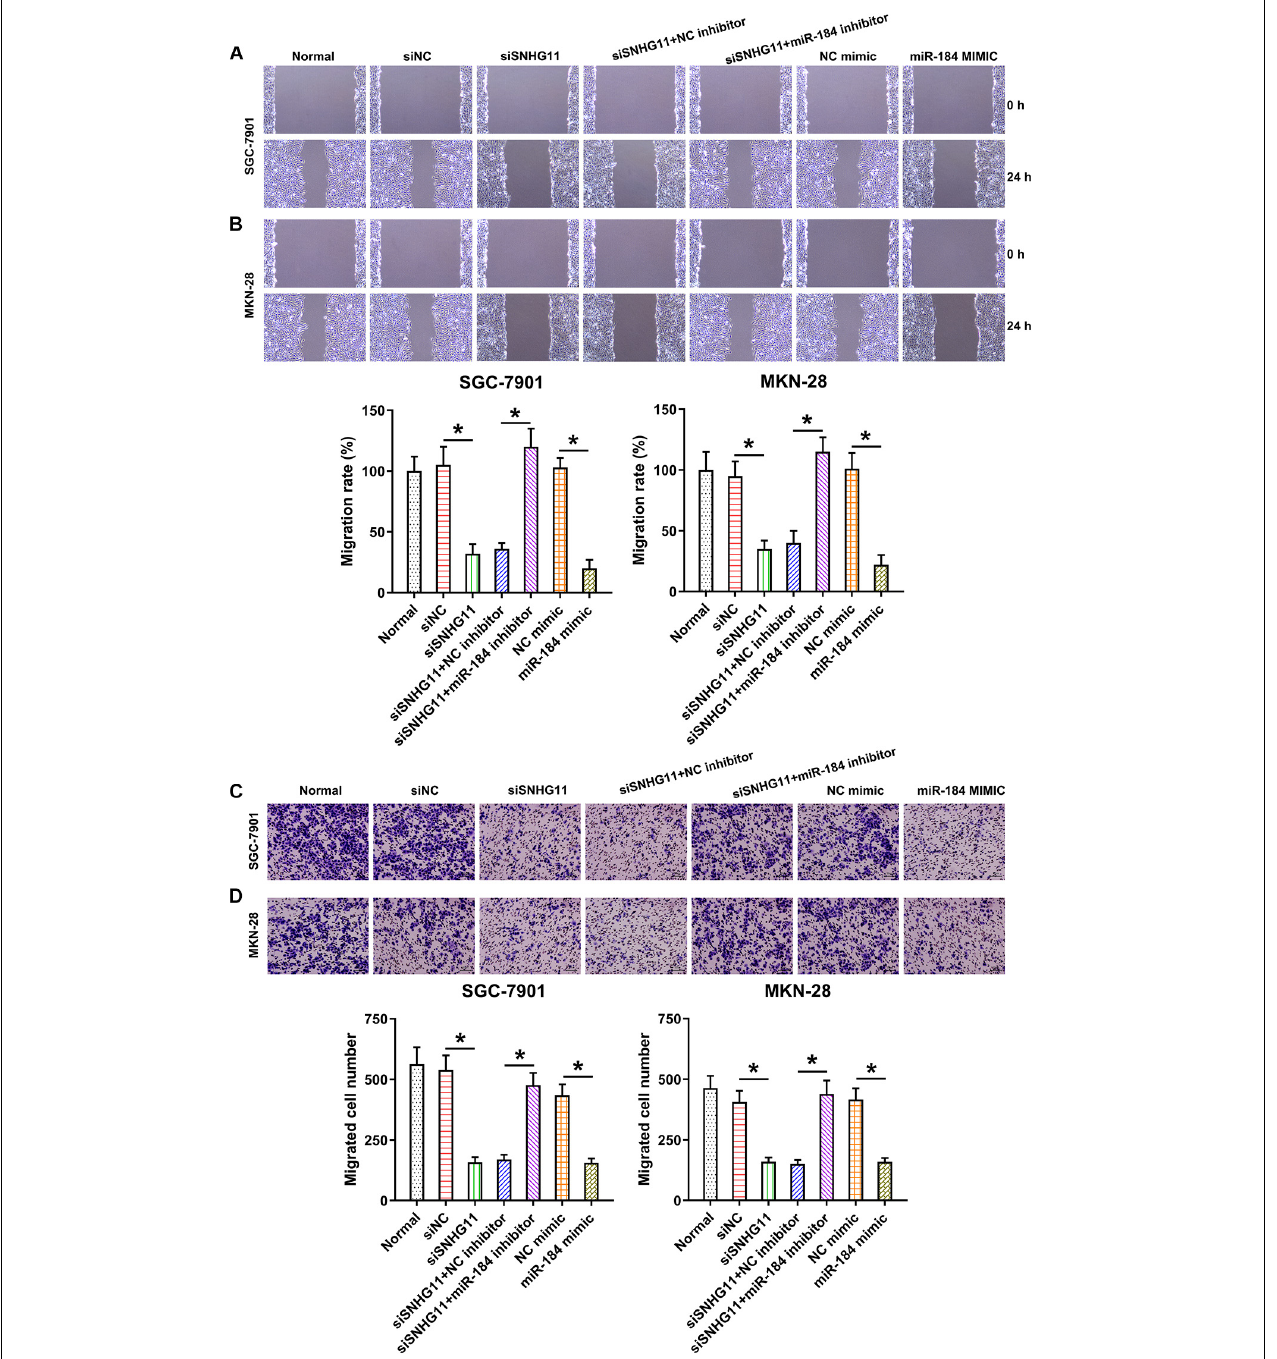
FIGURE 6 | The effect of SNHG11 and miR-184 on MKN-28 and SGC-7901 cells’ migration and intrusion. MKN-28 and SGC-7901 cells were subjected to NC shRNA, SNHG11 shRNA, SNHG11 shRNA + NC inhibitor, SNHG11 shRNA + miR-184 inhibitor, NC mimic, and miR-184 mimic for 36 h, or not. (A,B) Migration and (C,D) intrusion capacity was measured by WHA and TMA. “Normal” represents non-transfected cells. These data are shown as average ± SD . * P < 0.05 vs. indicated groups.